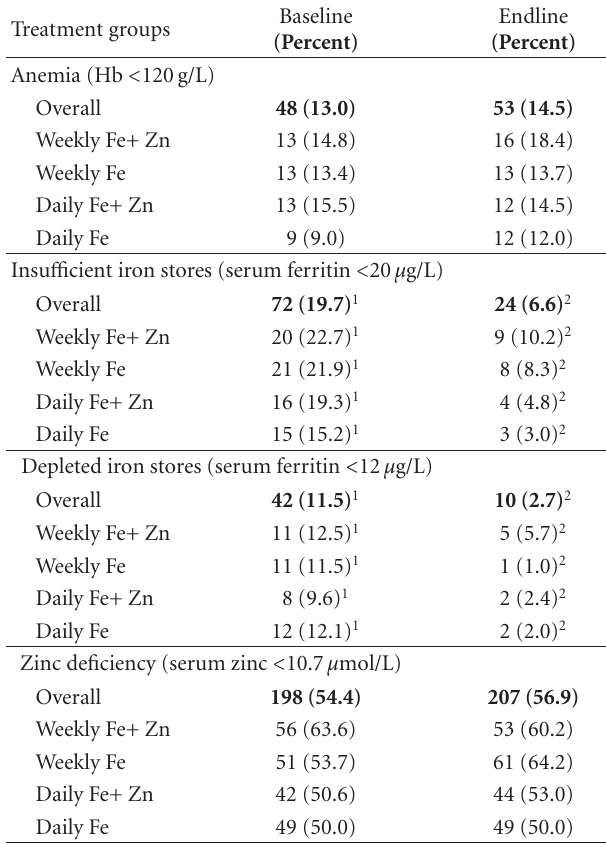
Table 3: Anemia, iron, and zinc deficiency in women before and after daily or weekly supplementation for 12